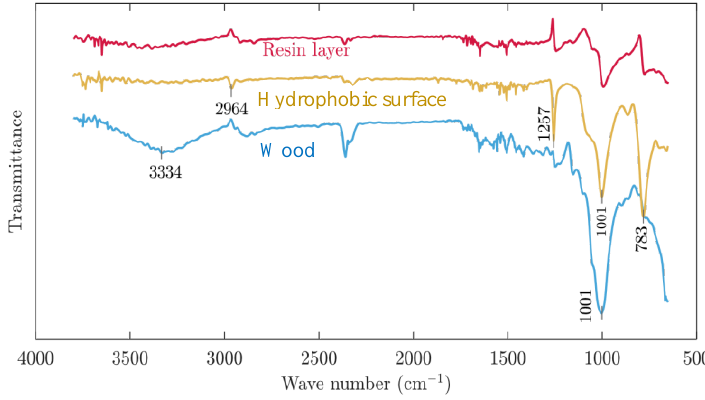
Figure 7. The infrared spectrum of the wood surface before and after treatment.